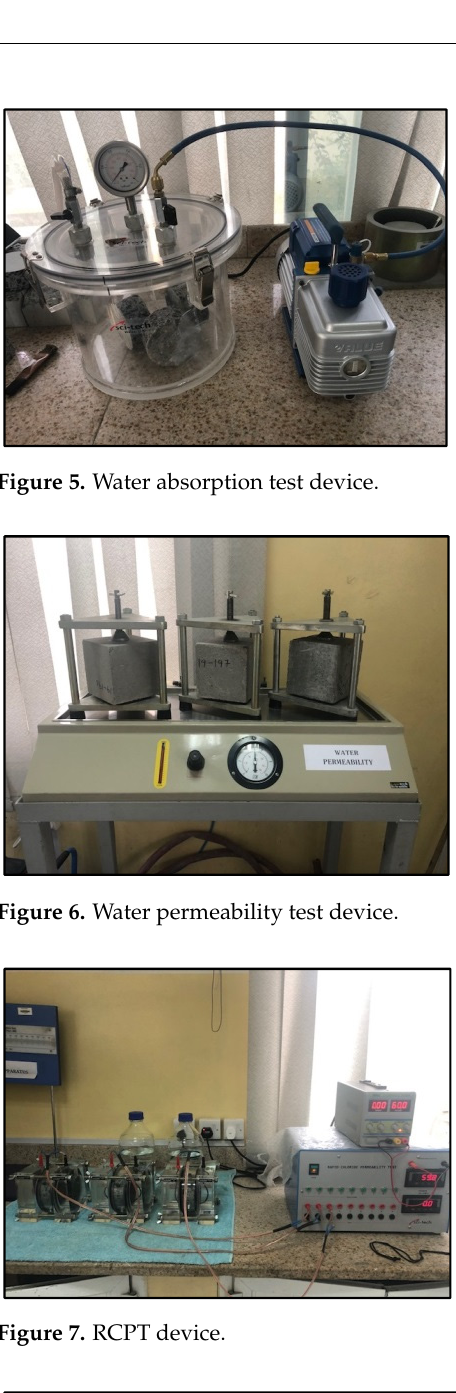
6 of 20 Figure 2. V-funnel test. Figure 3. L-box test.